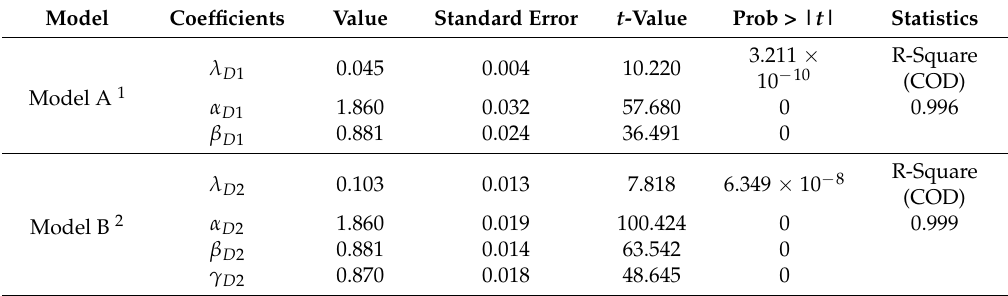
Table 5. Curve fitting results for material-drilling power of the JTVM6540 CNC milling machine. Model